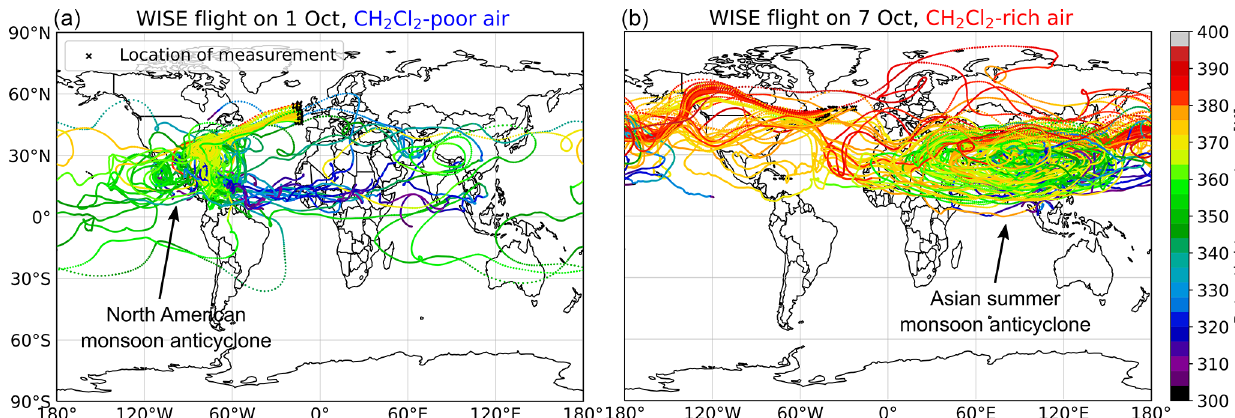
Figure 8. Back trajectories from the location of measurement to the model boundary layer for CH 2 Cl 2 -poor air sampled on 1 October (a) and for CH 2 Cl 2 -rich air sampled on 7 October (b) , color coded with the potential temperature of the trajectory. The trajectories of CH 2 Cl 2 -poor air show an uplift above Central America to about 365K, an isentropic northward drag towards an anticyclonic system above North America, an eastward breakout, and a direct and isentropic pathway into the extratropics above the Atlantic Ocean. The trajectories of CH 2 Cl 2 -rich air show an uplift above southern and eastern Asia up to about 360K with further upward transport by the ASMA to about 385K and a breakout eastwards following the subtropical jet stream until they quasi-isentropically enter the extratropics above the eastern Pacific or western Atlantic